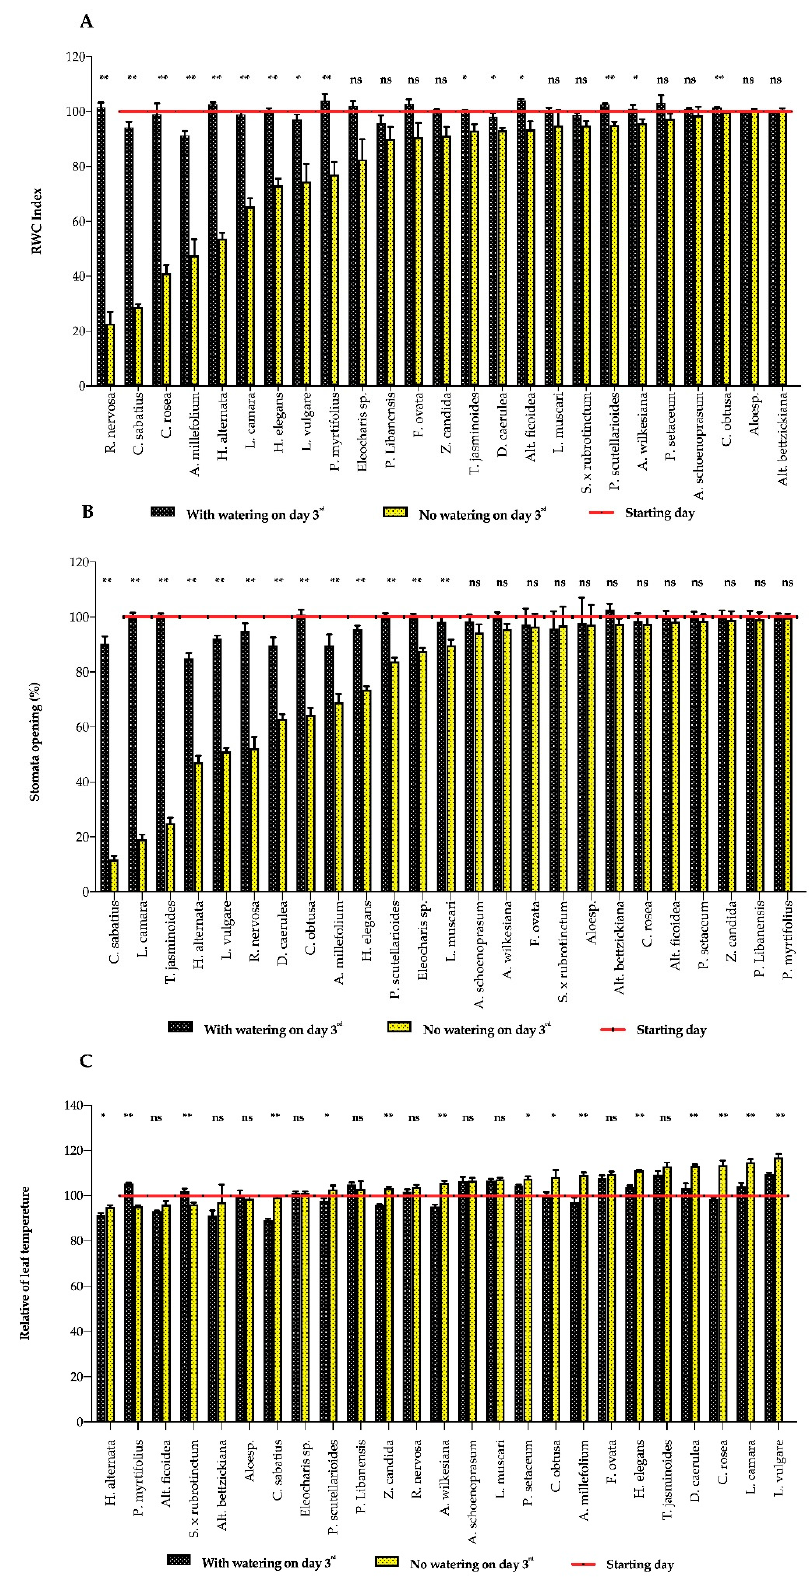
Figure 2. Effect of water deficiency on the relative water content index in leaves ( A ), percent stomata opening ( B ) and relative leaf temperature ( C ) on the 3rd day of the experiment for different plant species. Bars and error bars represeant mean ± SE. Non significant (ns) and significant differences (* at p < 0.05 and ** at p < 0.01 by Student’s T-test between no watering at 3 days are shown above the